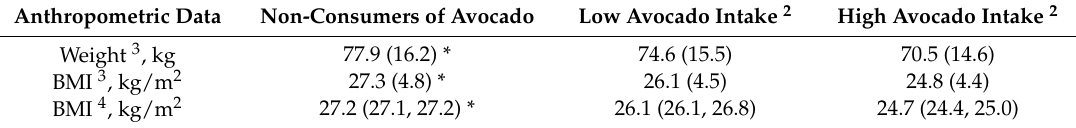
Table 2. Baseline weight and BMI by level of avocado intake in the Adventist Health Study-2 cohort 1